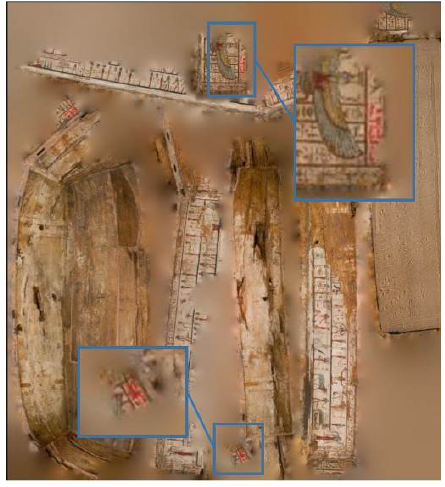
Figure 6. The difficulties in outlining the words in the texture of the objects because of the mosaic blending.